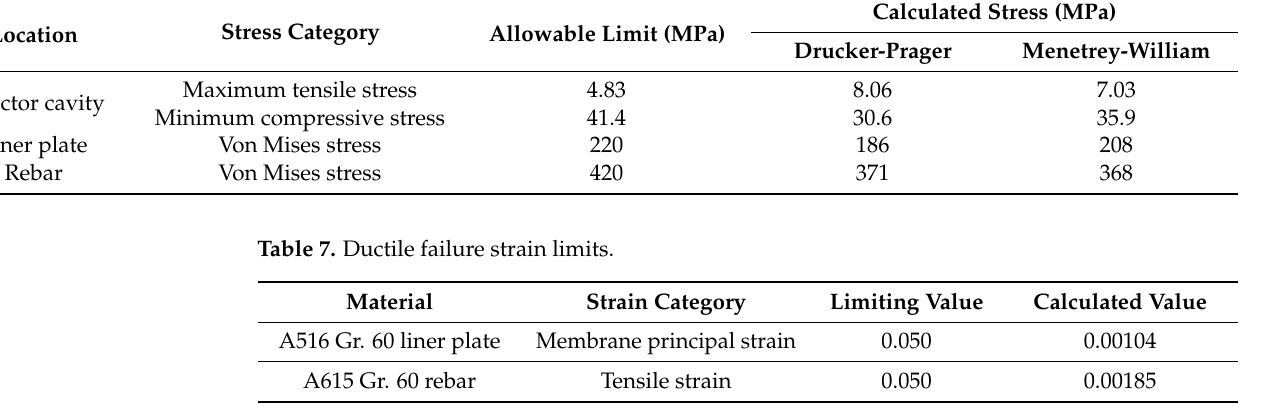
Figure 11. Membrane principal strain distribution in the liner plate. ( a ) The Drucker-Prager model. ( b ) The Menetrey-William model.